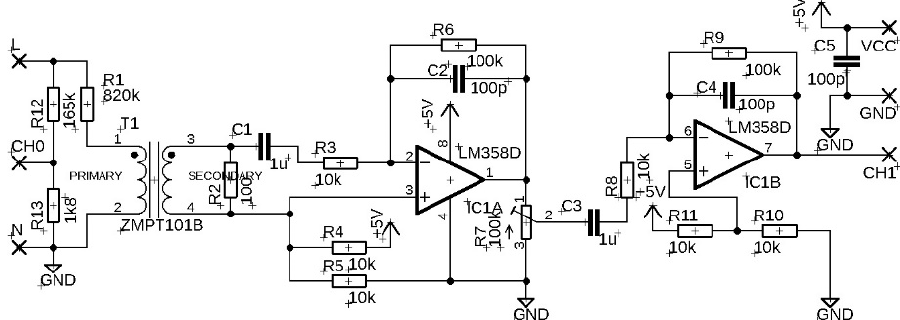
Figure 4. The wiring of the ZMPT101B single-phase AC voltage sensor and its internal diagram. The fourth tested fixture was a stand-alone current transformer ZMPT101B. The transformer consists of galvanically isolated primary and secondary windings with a 1:1 ratio wound on a toroidal ferrite core. The line voltage was applied to the primary winding through a 150 k Ω limiting resistor. The mains voltage applied to the input terminals of the fixture was monitored at the output of the resistive divider, and the bipolar output signal was recorded on the measuring resistor 500 Ω . The unconnected standalone current transformer is shown in Figure 1d. The wiring diagram of the fixture is shown in Figure 5.